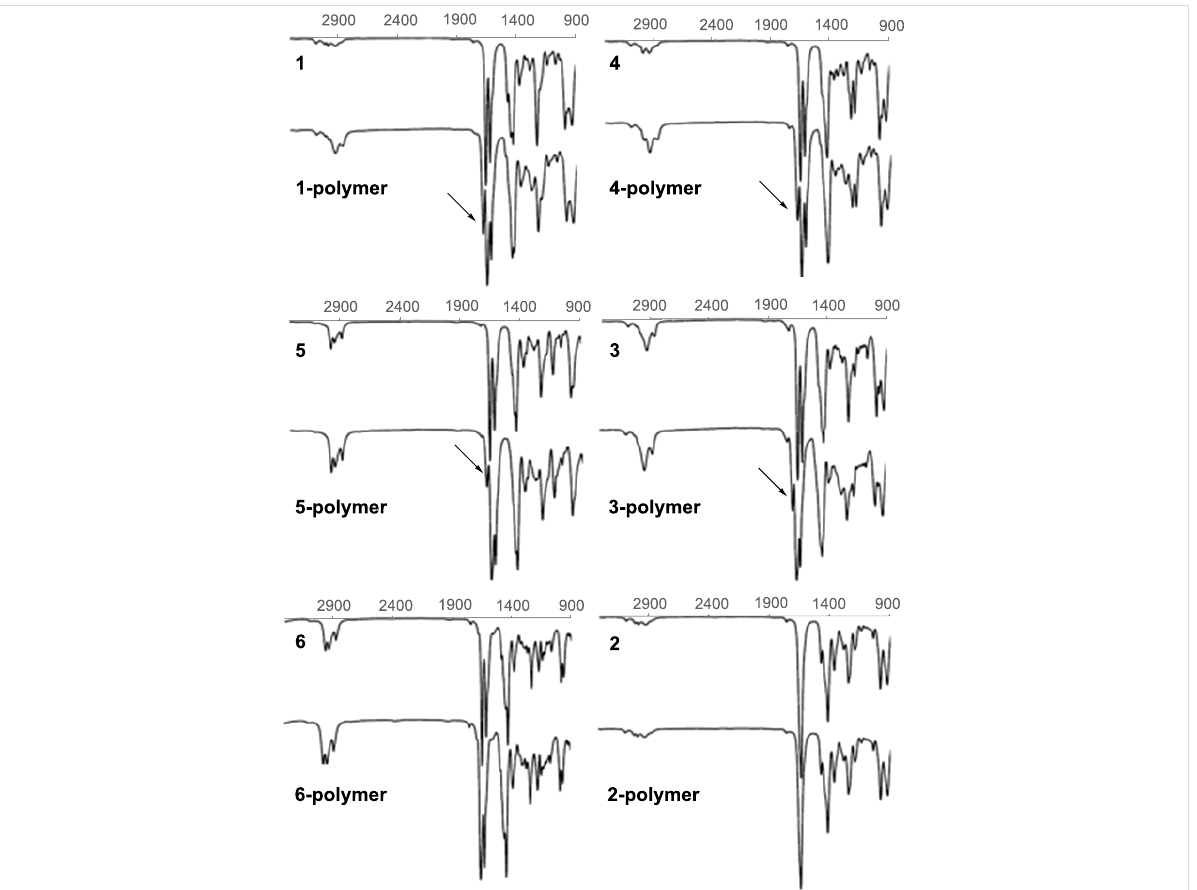
Figure 6: FTIR spectra of 1–6 before (top) and after (bottom) curing; the arrows indicate emerging, characteristic γ -lactam vibration at ~1680 cm − 1 for polymers 1 and 3–5 .